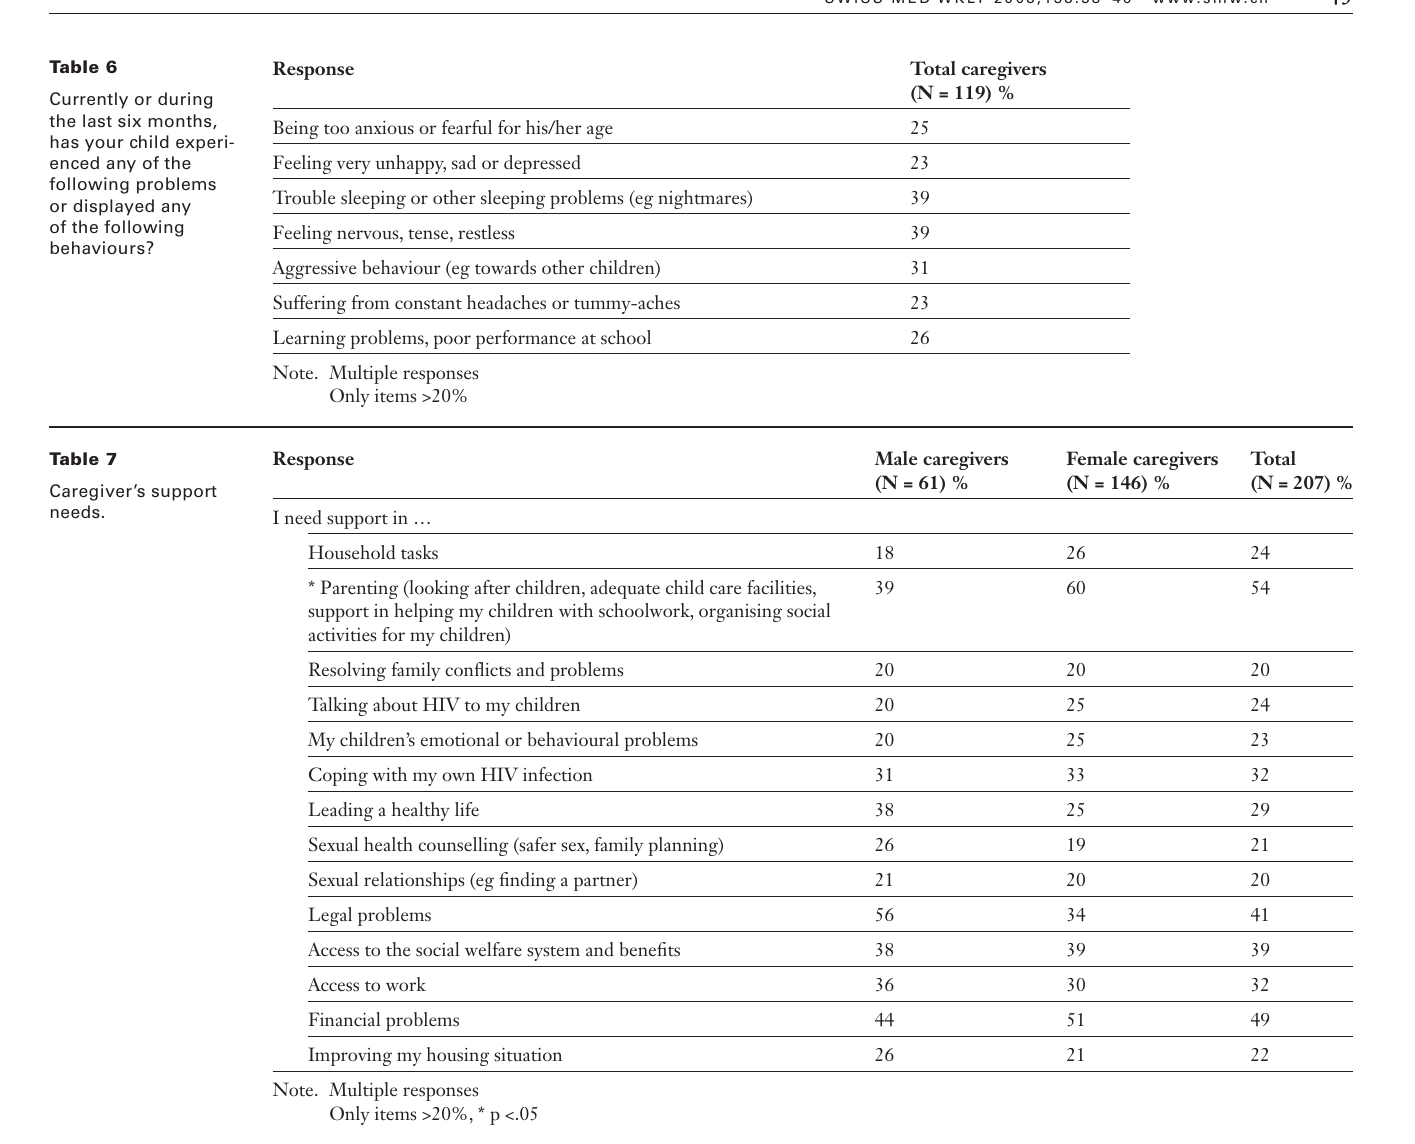
Support require- ments from people or